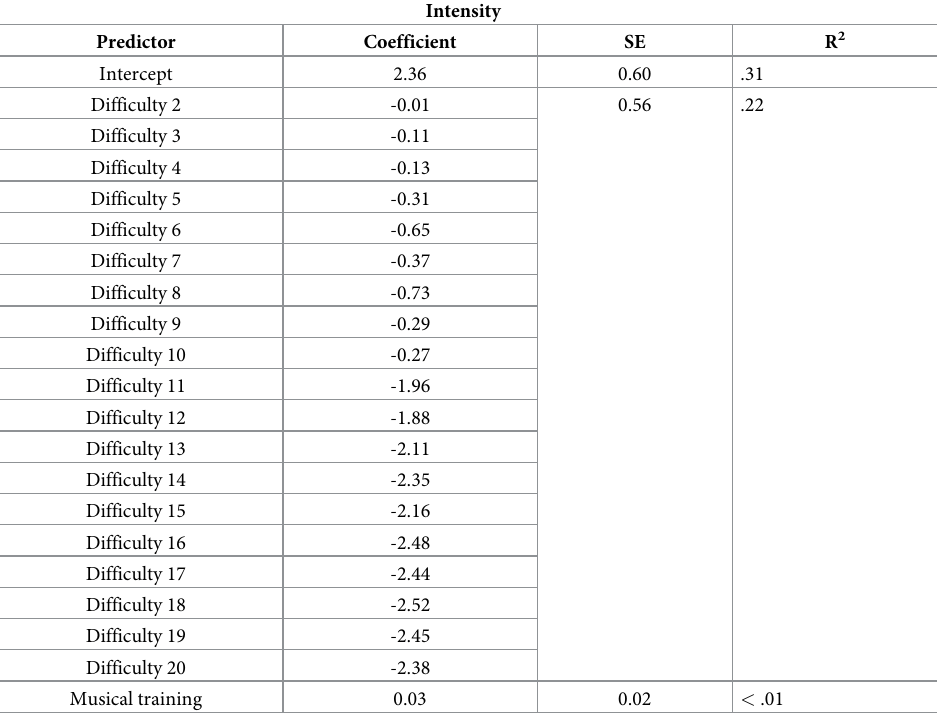
Table 2. Mixed effects multiple linear regression model for intensity feature. Coefficients for each predictor (and each degree of difficulty, as relevant) along with standard error (SE) and predictor R 2 are reported along with Pearson’s correlation, 95% CIs, p-value and R 2 for full models in the note